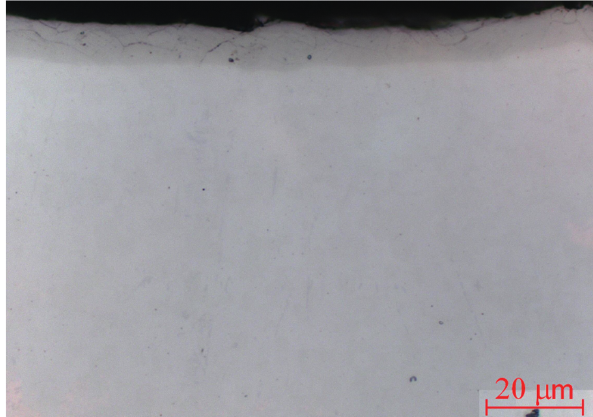
Figure 6: Cross-section of a nitrided sample, treatment time 60 min Nitriding temperature 490°C, sample bias – 750 V, sample current density 1.4 mA/cm 2 , layer microhardness 13.6 GPa.